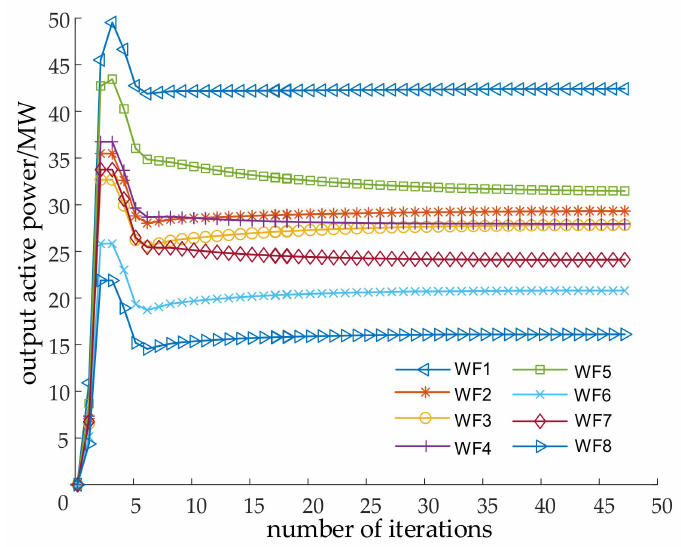
Figure 7. Active output convergence curve of each wind